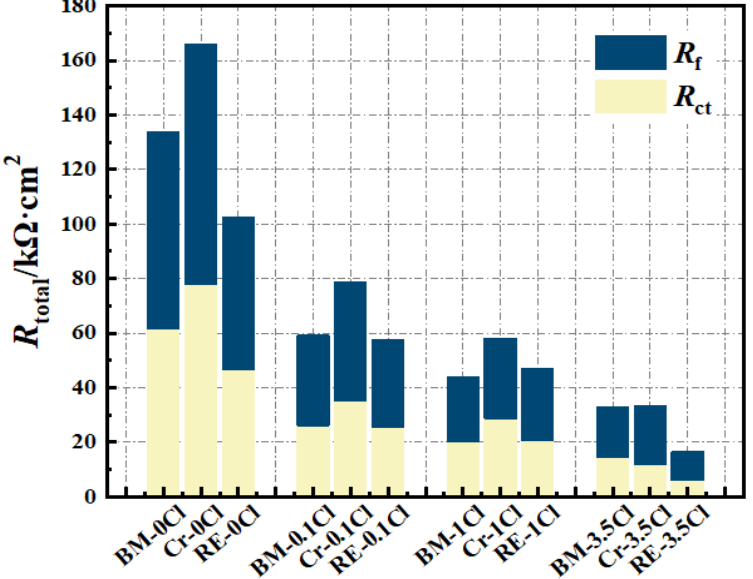
Figure 9. R total ( R f + R ct ) of the passive film for the three steel rebars in simulated solutions. Table 1. Fitted results of EIS data for the passive film on steel rebars.